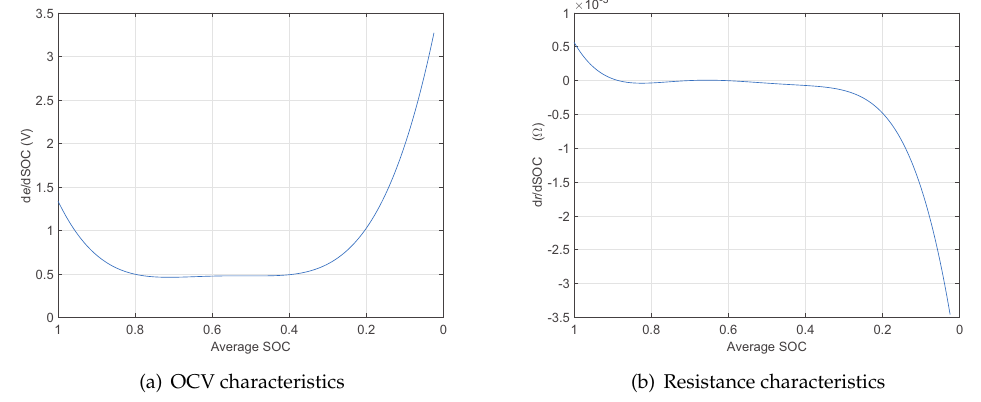
Figure 16. Parameter characteristics. OCV, open circuit